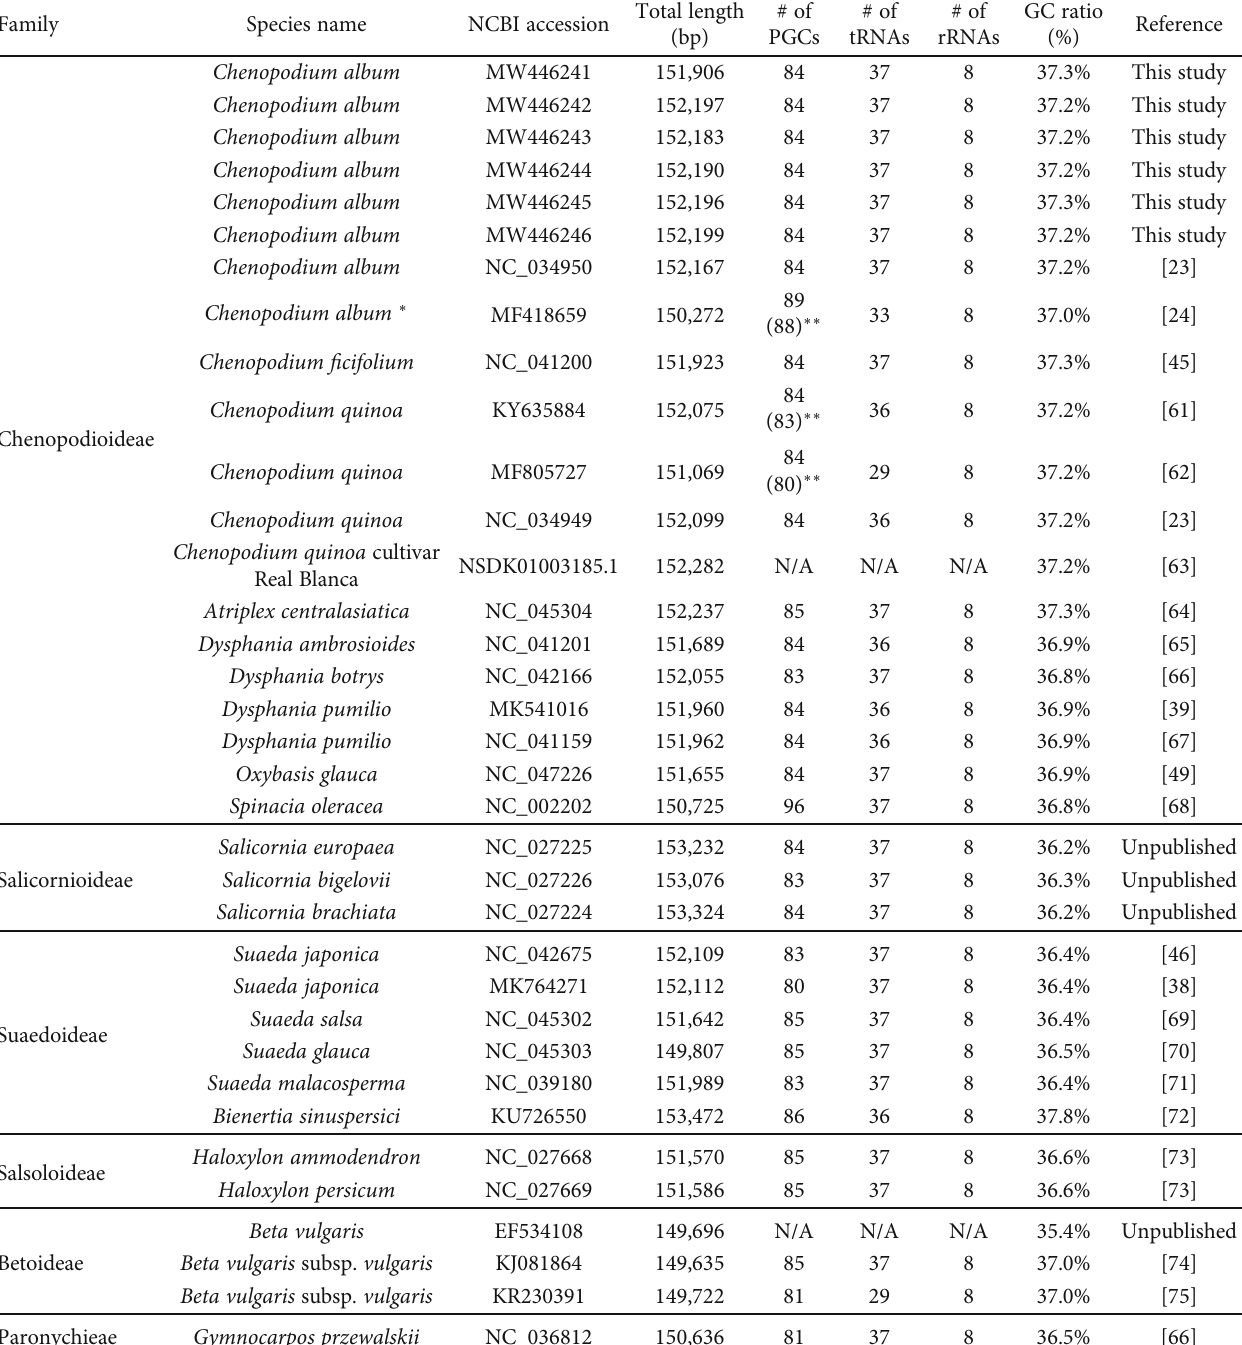
Table 3: List of chloroplast genomes used for comparative analyses in this